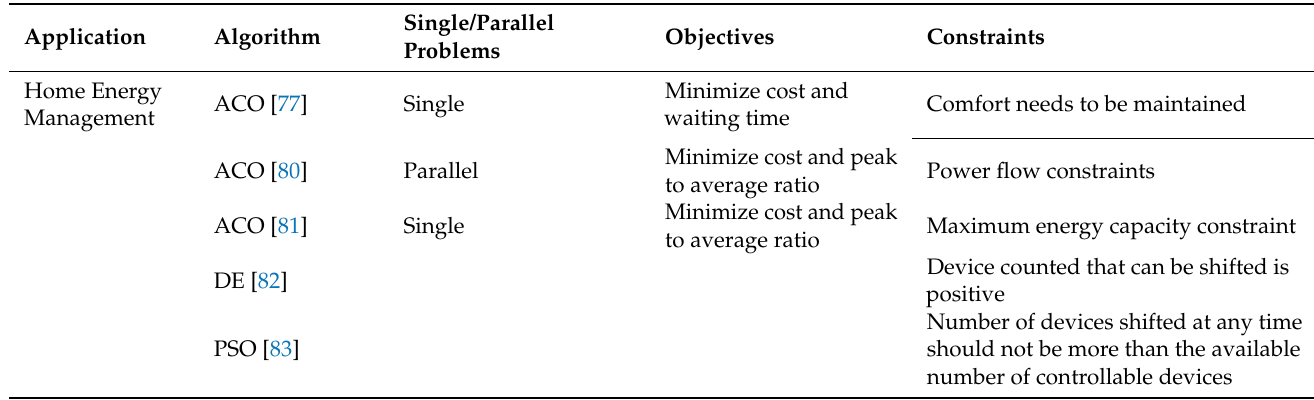
Table 9. Optimization in Smart